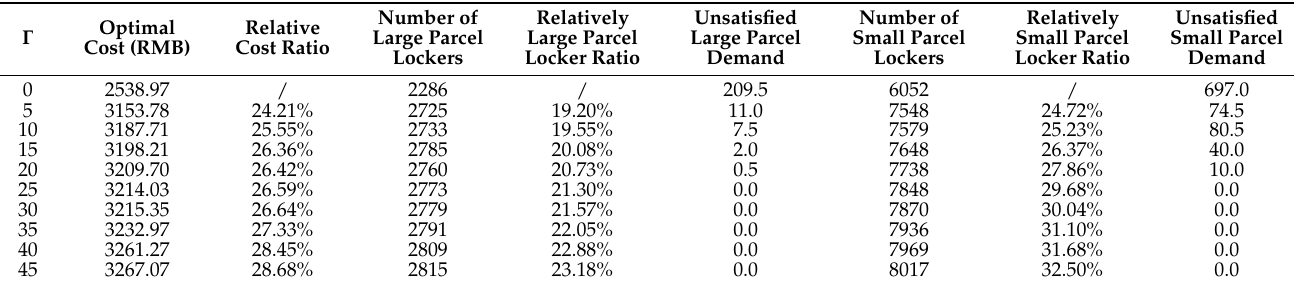
Table 5. Results on the examination of the influence of Γ on the